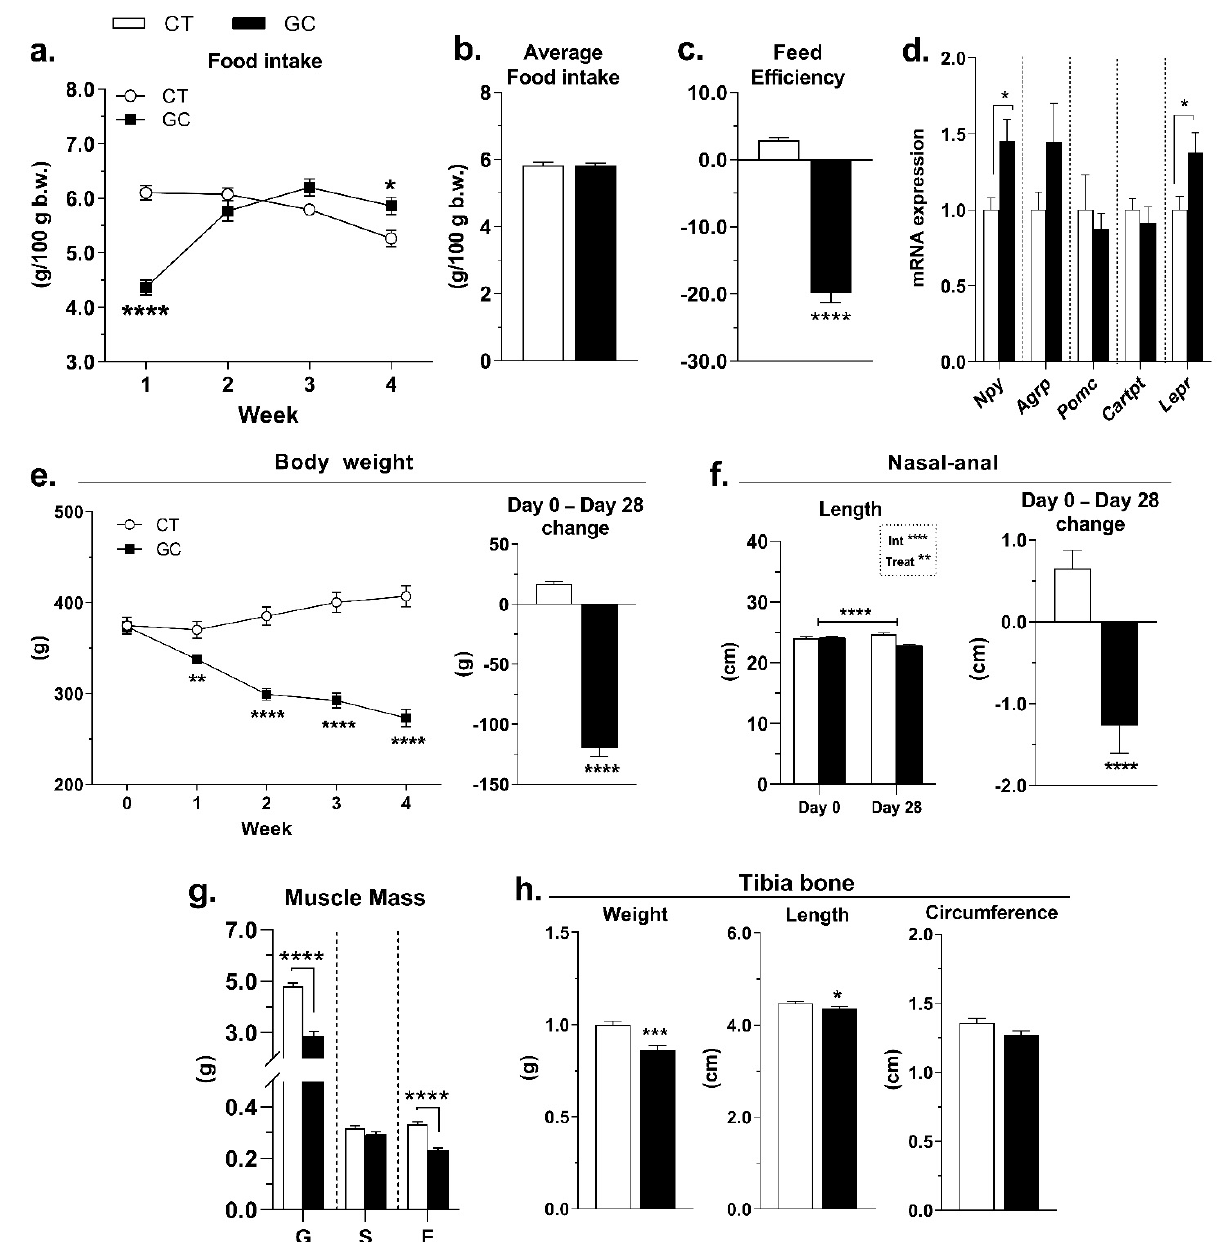
Figure 3. Food intake and body changes in response to GC excess . ( a ) Daily food intake per week; ( b ) average 28 days daily food intake; ( c ) feed efficiency; ( d ) hypothalamic gene expression of Npy